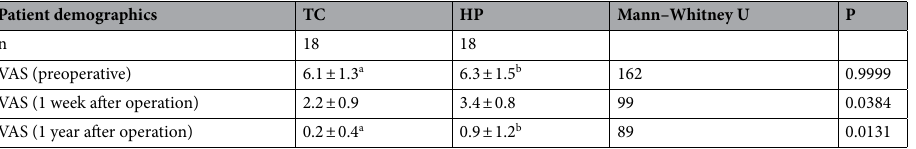
Table 3. Comparison of VAS score. a Compared with VAS (pre-operate) and VAS (1 year after operate) of TC group, Wilcoxon test, median = − 6, P < 0.0001. b Compared with VAS (pre-operate) and VAS (1 year after operate) of HP group, Wilcoxon test, median = − 5, P < 0.0001.